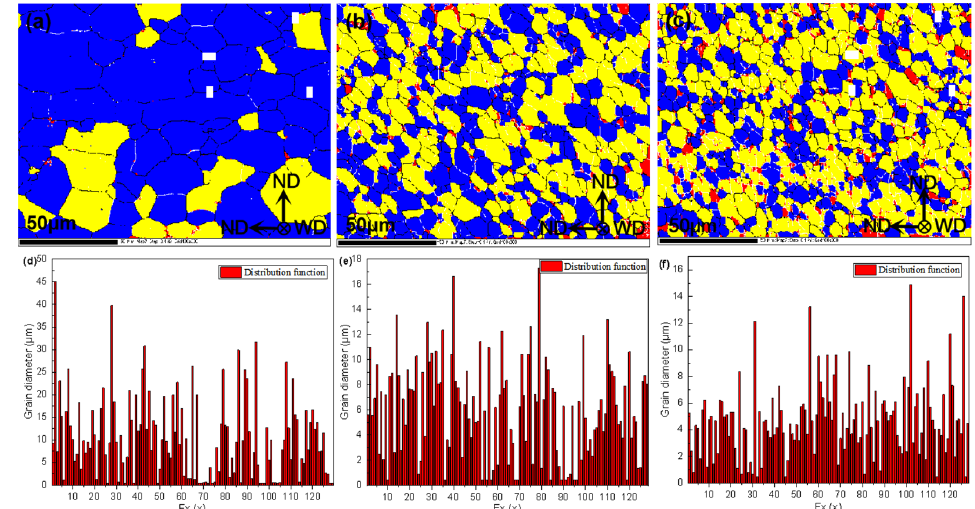
Figure 9. Microstructure, morphology and grain size, ( a , d ) BM, ( b , e ) NZ at 6000 rpm, ( c , f ) NZ at 12,000